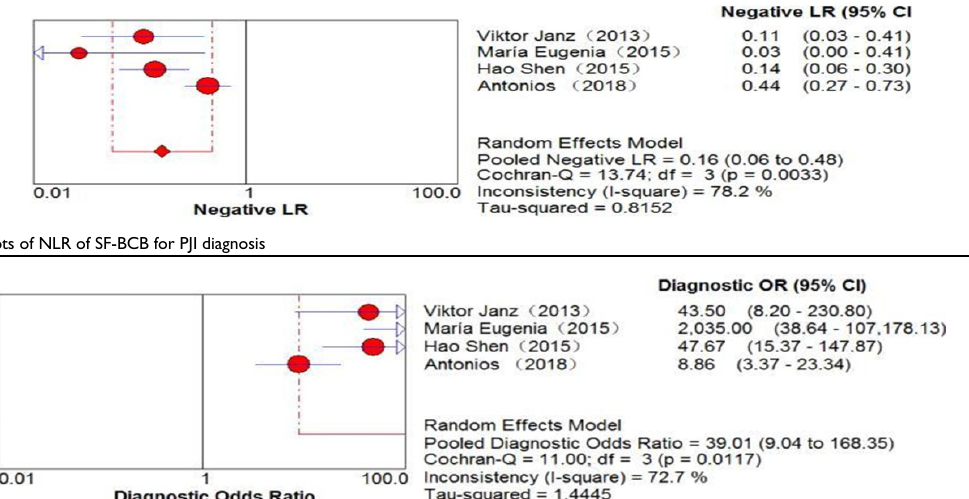
Figure 6. Forest plots of PLR of SF-BCB for PJI diagnosis